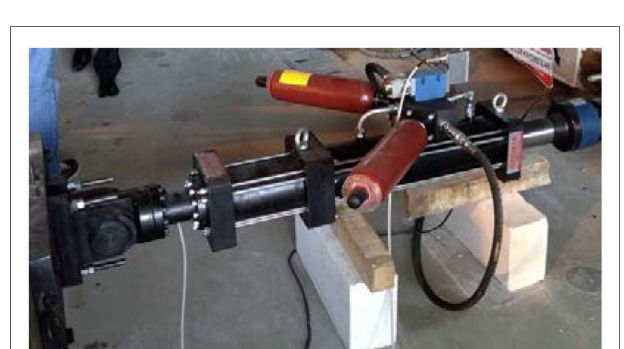
FigUre 4 | steel supports of the test setup fixed to the laboratory rigid floor .